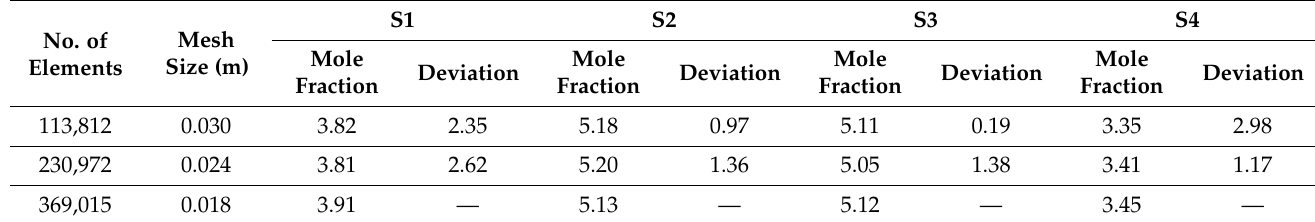
Table 2. Mesh convergence